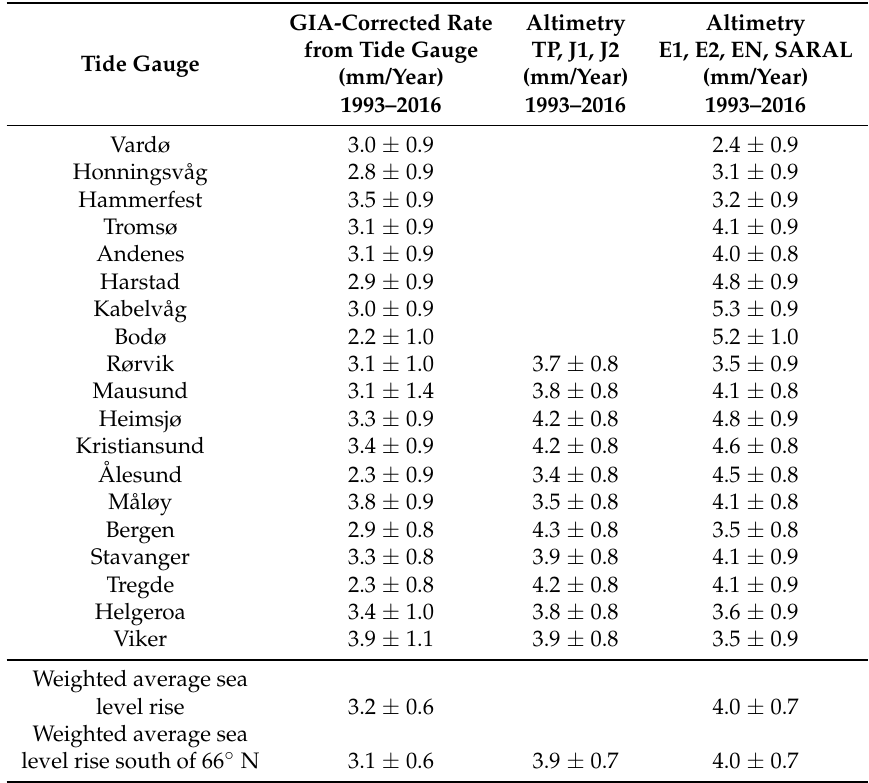
Table 3. Sea-level rates observed by altimetry and rates from tide-gauge records for the period 1993 to 2016. The tide gauges are ordered along the coast from north to south. The weighted average of the rates is given for all locations and for those south of 66 ◦ N. Note that the altimetry data are corrected for geoid changes associated with GIA and that the tide-gauge records are corrected for the inverse barometer effect. Records with too short duration or with significant data gaps are excluded from the analysis. The altimetry data were collected by the satellite missions TOPEX/POSEIDON (TP),